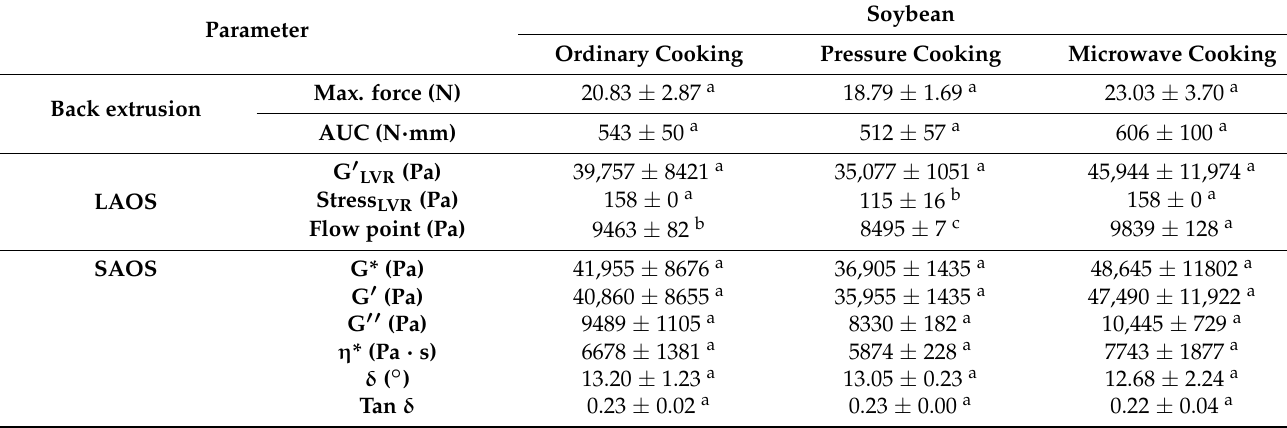
Table 2. Texture and viscoelastic properties of legume pastes from soybean, lentil, and pea subjected to different cooking treatments. Soybean Parameter Ordinary Cooking Microwave Cooking Back extrusion